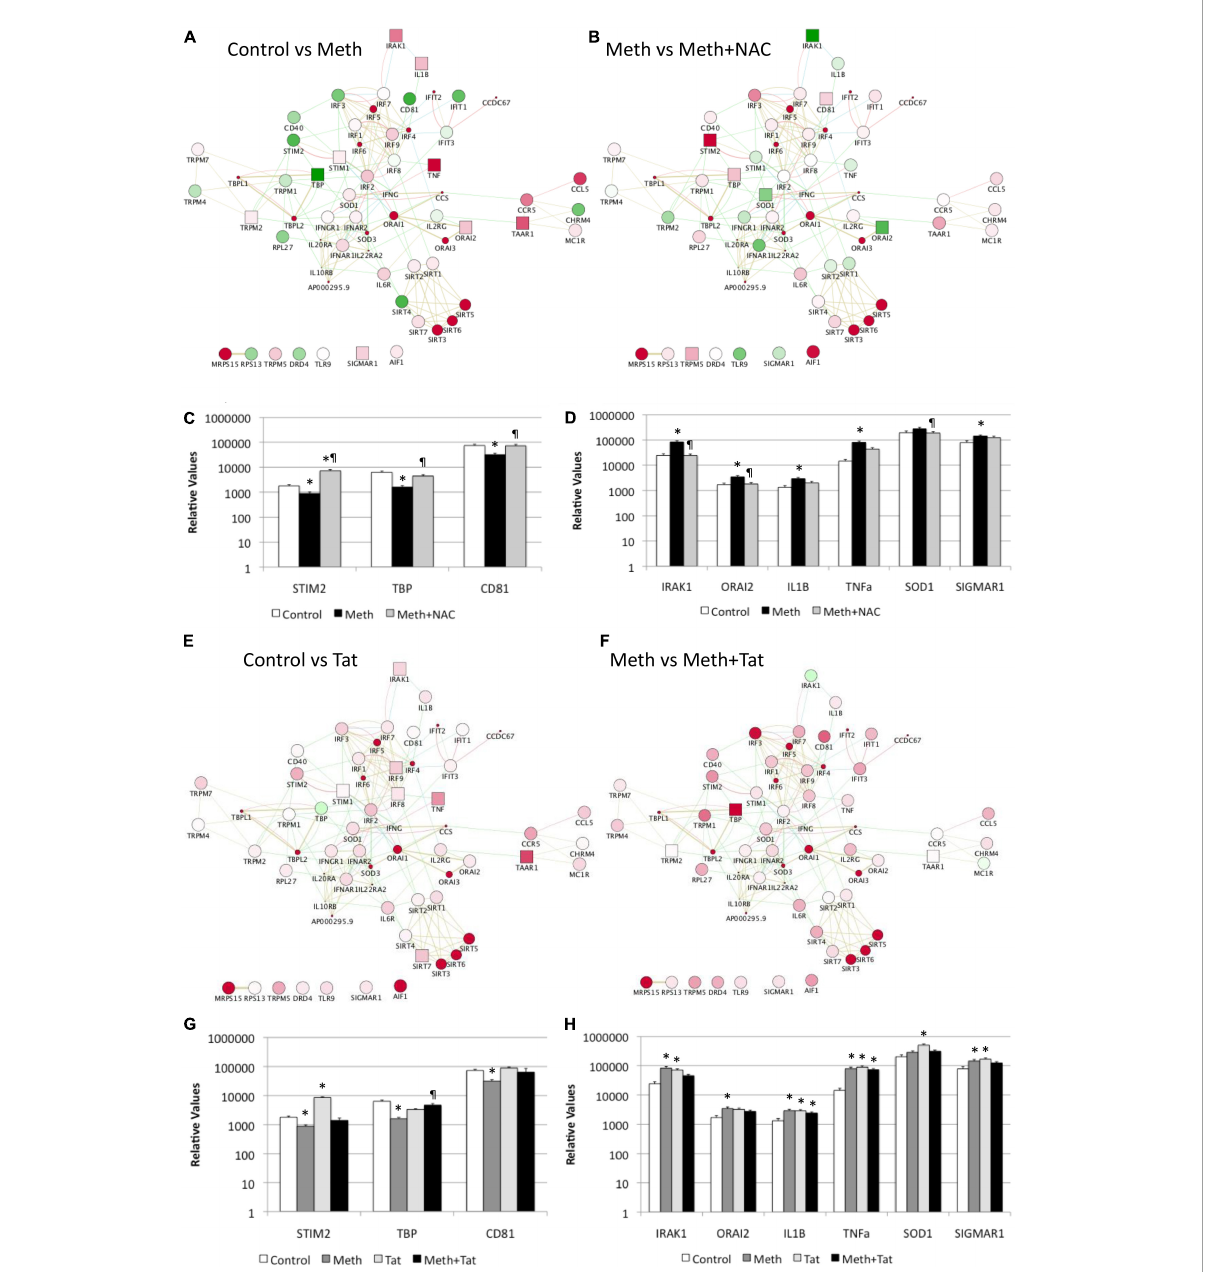
FIGURE5 Effect of Meth-induced ROS and HIV Tat on RNAPol recruitment to promoter intervals in macrophages, and on transcription of selected genes. RNAPol peak values from ChIP, in THP1 cells treated with Meth (60 uM) for 15 min. Patterns were identified in Cytoscape, via GeneMania and JActiveModules. The highest score node was selected for further analysis. (A) The behavior of the highest score gene cluster was compared between Meth and control, vehicle-treated cells. (B) The behavior of the highest score gene cluster was compared between Meth + NAC and Meth alone-treated cells. Shades of red indicate levels of upregulation, and shades of green show levels of downregulation of RNAPol accumulation/promoter activity. Squares correspond to changes that were statistically significant. Validation was performed by measuring mRNA transcription with qRT-PCR, 2 h after treatments. (C) Transcription of genes with RNAPol activity decreased by Meth and reverted by NAC. (D) Transcription of genes with RNAPol activity increased by Meth and reverted by NAC. The impact of Tat (10ng/ml) was evaluated in the genes in the validated gene cluster. * p < 0.05 compared to control. (cid:60) p < 0.05 compared to Meth. (E) The behavior of the highest score gene cluster was compared between Tat and control, vehicle-treated cells. (F) The behavior of the highest score gene cluster was compared between Meth and Meth + Tat-treated cells. Shades of red indicate levels of upregulation, and shades of green show levels of downregulation of RNAPol accumulation/promoter activity. Squares correspond to changes that were statistically significant. Validation was performed by measuring mRNA transcription with qRT-PCR, 2 h after treatments. (G) Transcription of genes with RNAPol activity decreased by Meth and reverted by Tat. (H) Transcription of genes with RNAPol activity increased by Meth and by Tat. The impact of Tat (10ng/ml) was evaluated in the genes in the validated gene cluster. * p < 0.05 compared to control. (cid:60) p < 0.05 compared to